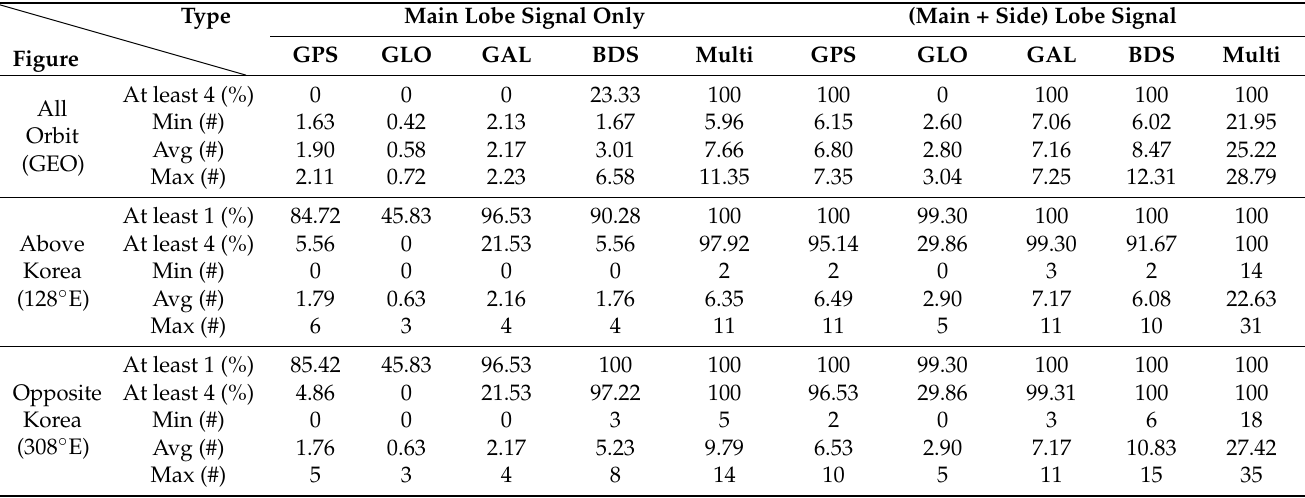
Table 2. GNSS satellite visibility for 24 h in geostationary orbit about the longitude.